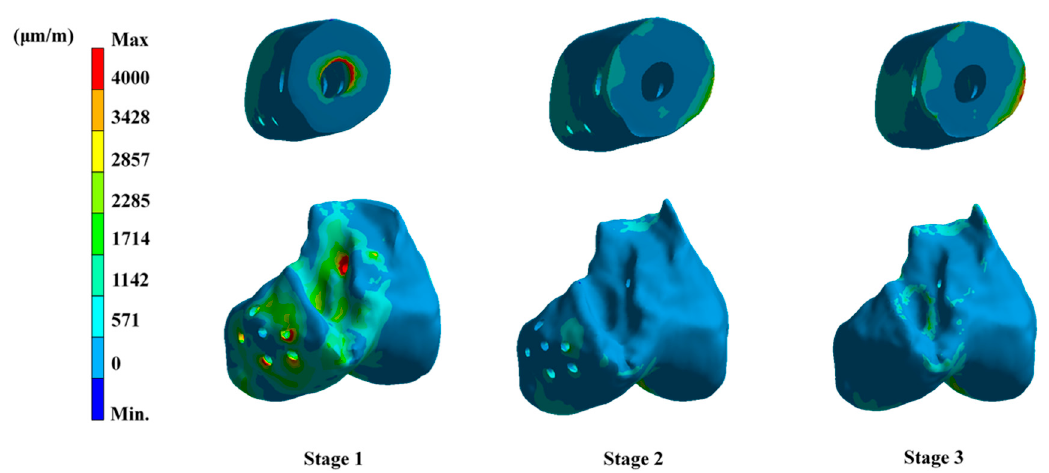
Figure 7. Most of the strain values were less than 4000 at the proximal and distal implant-bone contact interfaces and only a small amount was more than 4000 around the proximal stem and the distal bone nail in the stage 1.